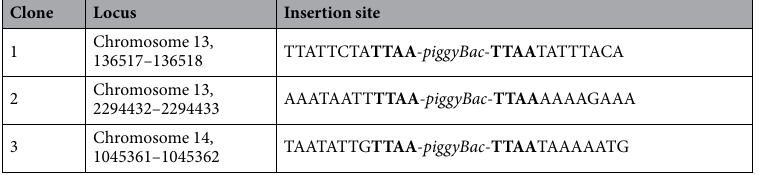
Table 1. piggyBac transposon insertion